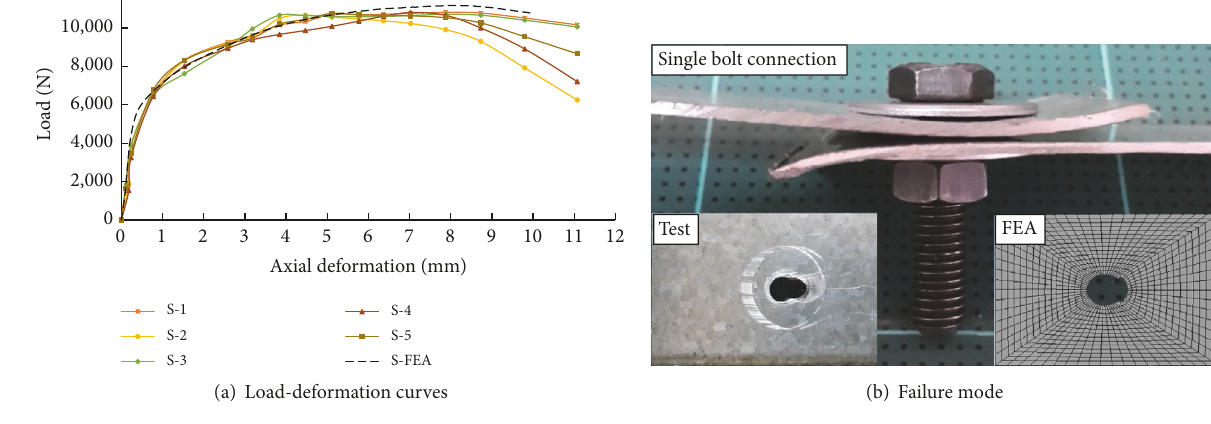
Figure 5: Load-deformation curves and failure mode of single bolted connection.